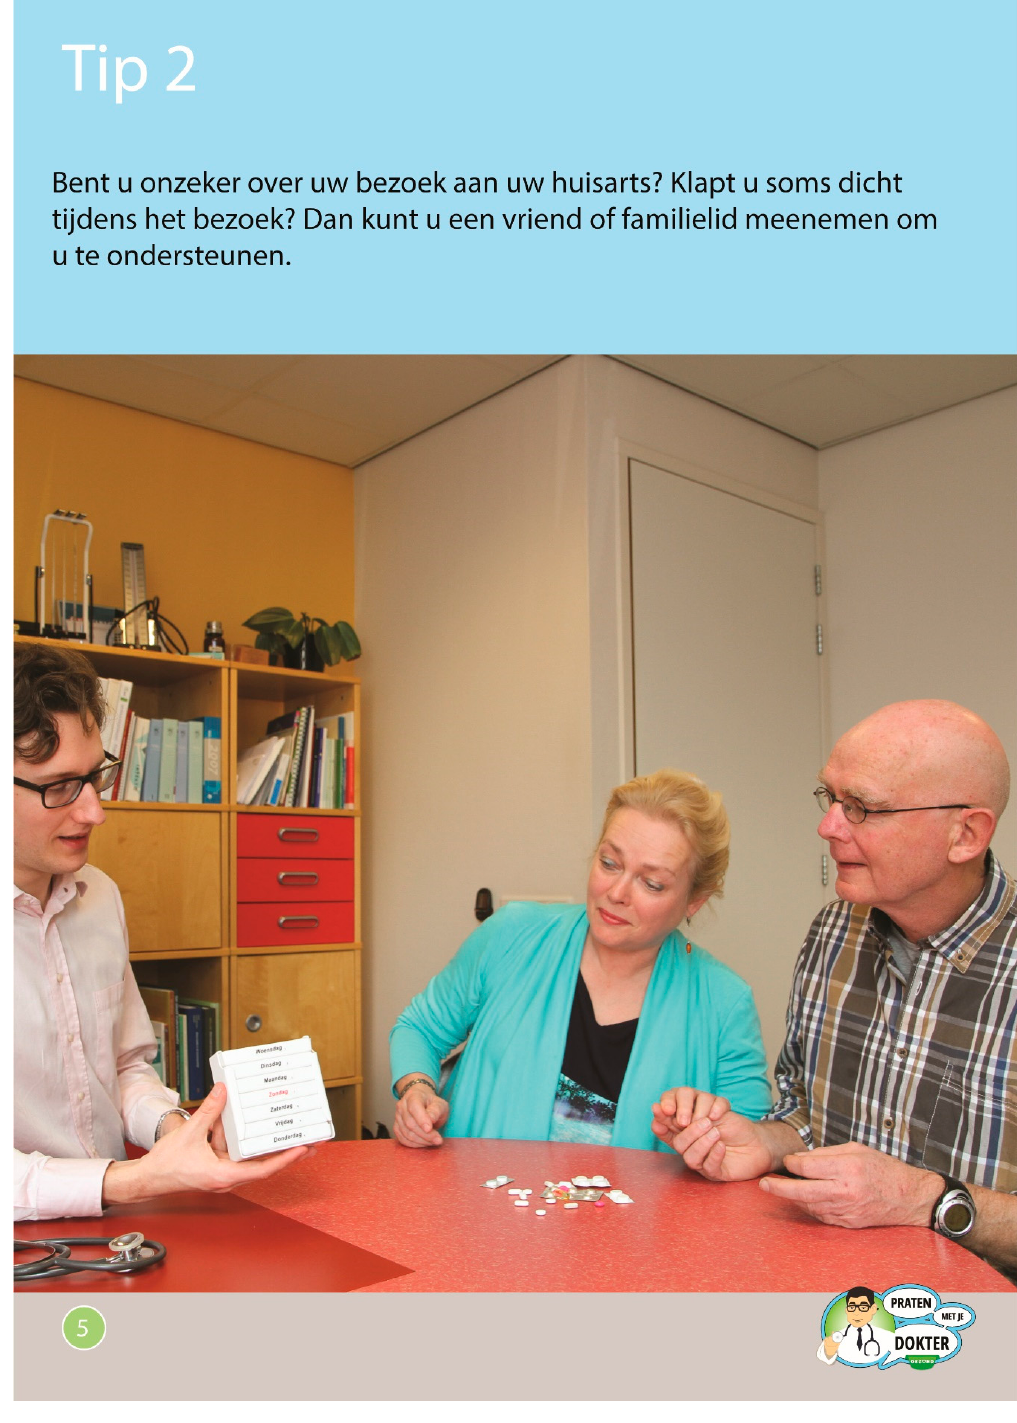
Figure 3. Example page in Dutch from the non-narrative brochure about bringing someone for support. Translation: Are you feeling insecure about visiting your General Practitioner? Are you sometimes at a loss for words during your visit? You can bring a friend or family member to support you.